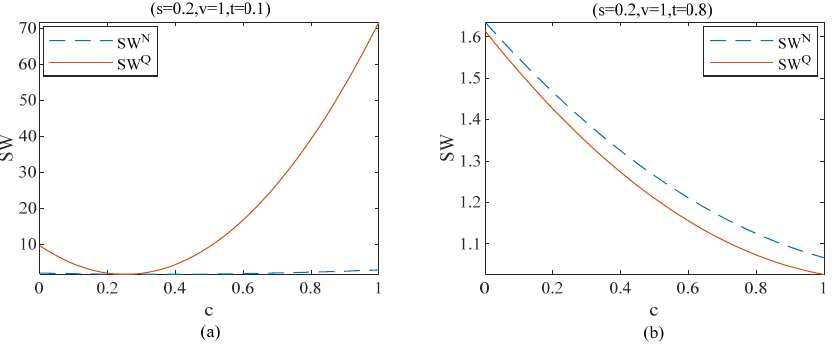
Figure 7. Social welfare in equilibrium ( t = 0.1 vs. t = 0.8).